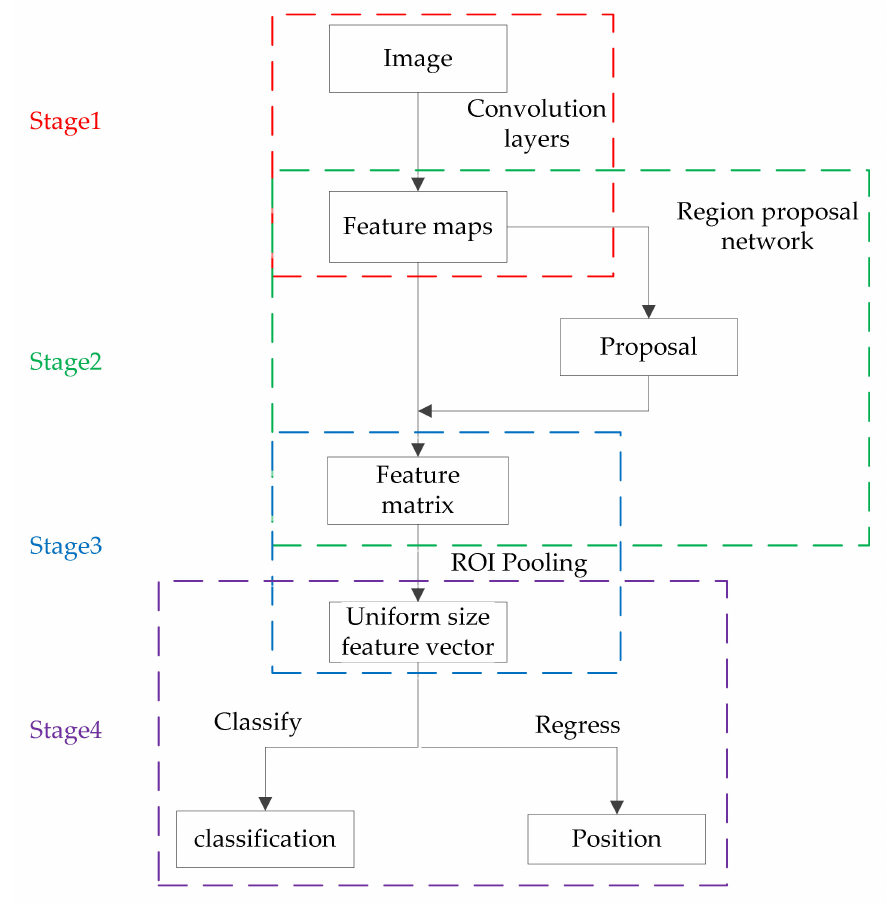
Figure 3. Flow chart of the Faster-RCNN